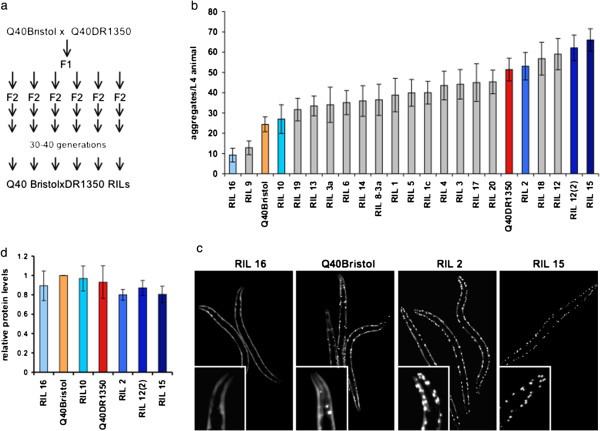
Multiple alleles control polyQ aggregation in Caenorhabditis elegans. (a) Scheme of generation of Q40Bristol × DR1350 recombinant inbred lines (RILs). To ensure genetic homogeneity within each RIL, 30 to 40 generations of self-reproduction were used. (b) Number of polyQ aggregates per L4 animal of parental strains and 21 RILs. Data are mean ± SD, 17 to 23 animals/data point. Colors correspond to selected strains as indicated in supplementary material (see Additional file 2: Figure S2a). (c) Images of representative animals used in (b); insets show head regions. (d) Western blotting analysis of total Q40-YFP protein levels in extracts of L3 animals, relative to Q40Bristol. Data are mean ± SD, n = 3.